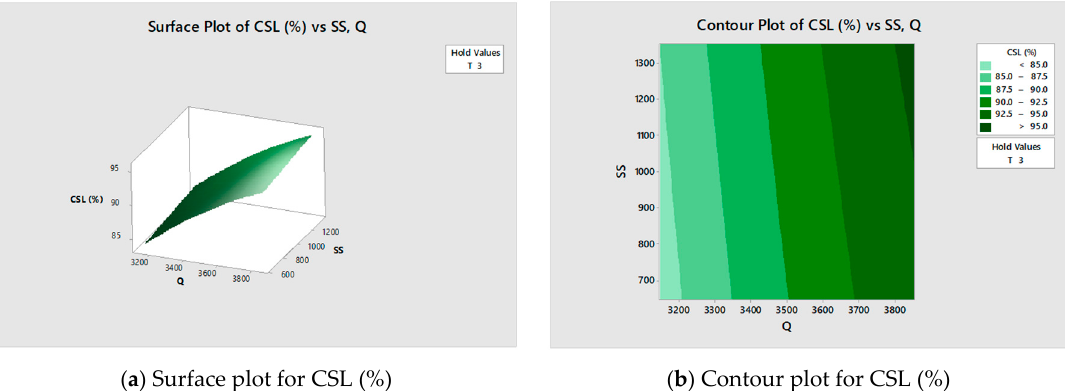
Figure 14. CCD—surface and contour plots for CSL (%).